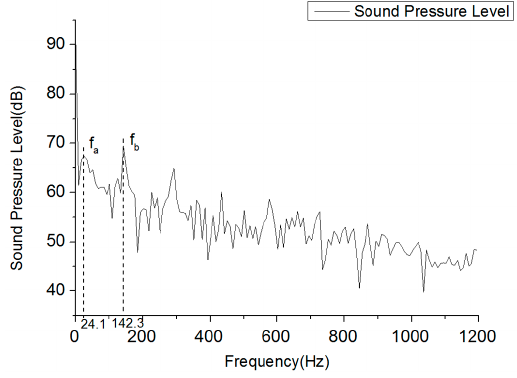
Figure 7. The sound spectra of receiver 1.